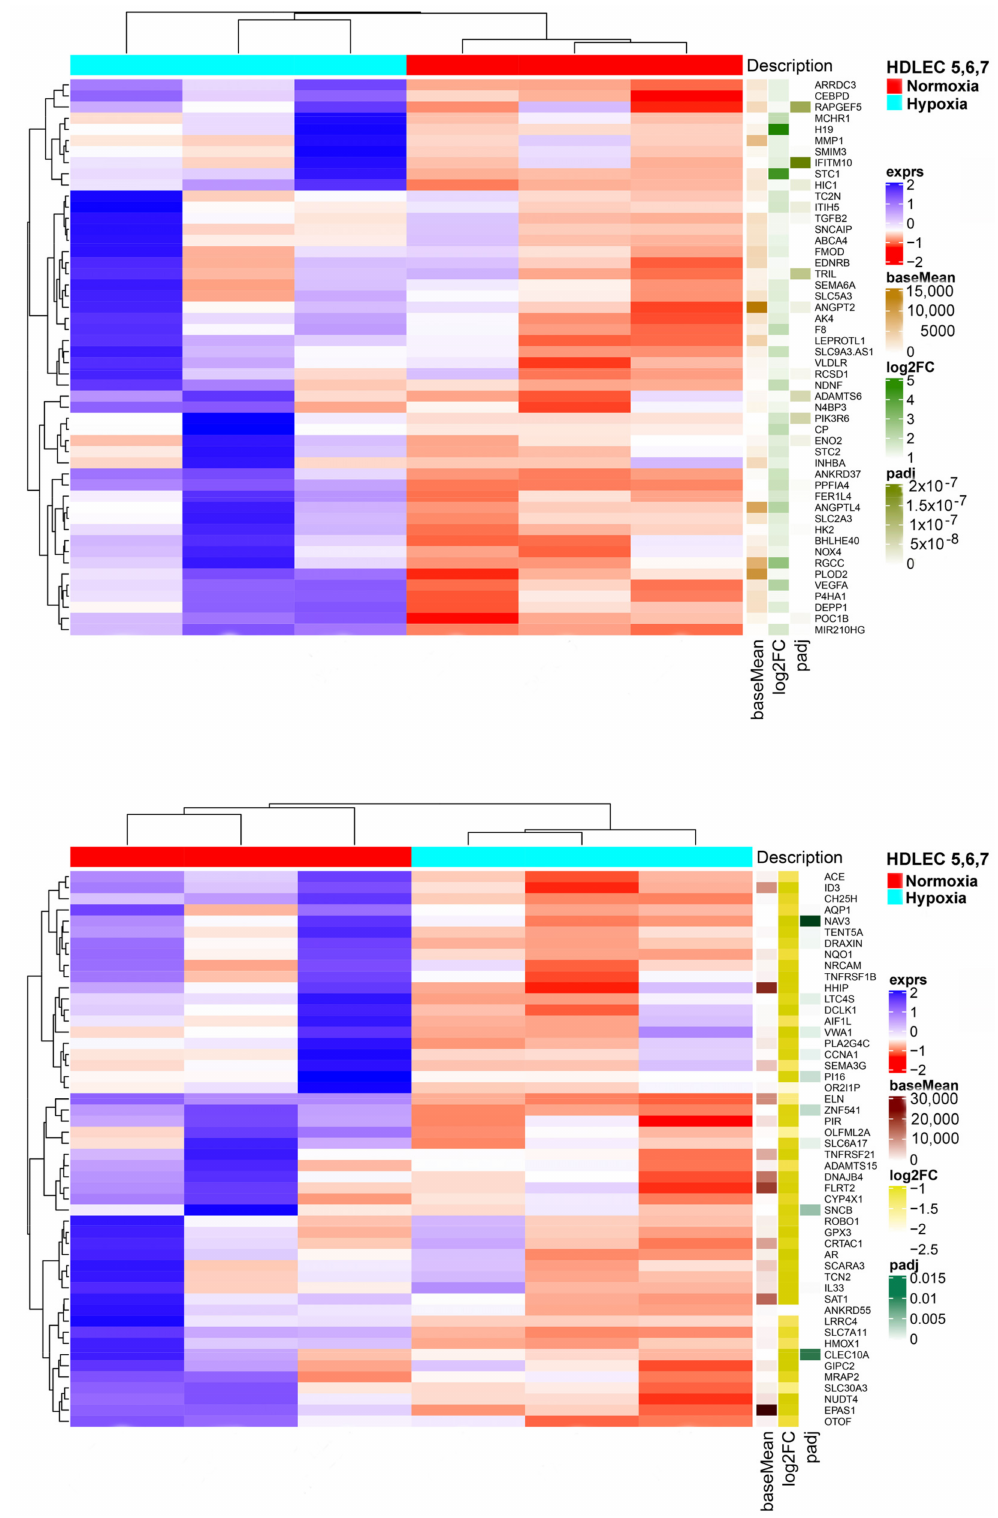
Figure 3. ( A ) Heatmap of the 50 most up-regulated differentially expressed genes in HD-LECs under hypoxia compared to normoxia. Produced with R version 3.6.3 and package ComplexHeatmap v2.0.0. (www.bioconductor.org/packages/ release/bioc/html/ComplexHeatmap.html). ( B ) Heatmap of the 50 most down-regulated differentially expressed genes in HD-LECs under hypoxia compared to normoxia. Produced with R version 3.6.3 and package ComplexHeatmap v2.0.0.